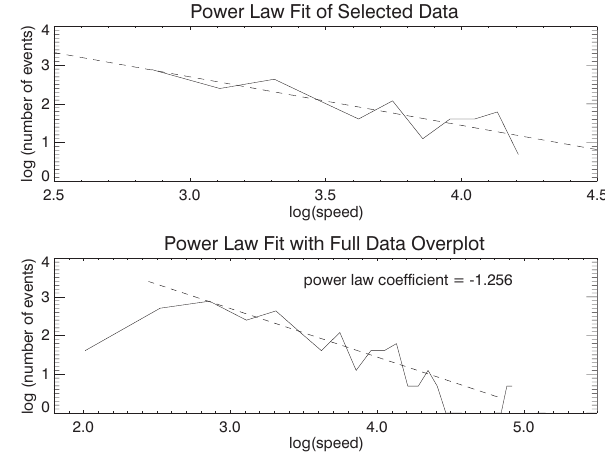
Fig. 7. Distribution of azimuthal expansion speeds of dipolarization fronts. Fig. 8. Log-log plot of the speed distribution in Fig. 7. Distribution follows a power law with an index of −